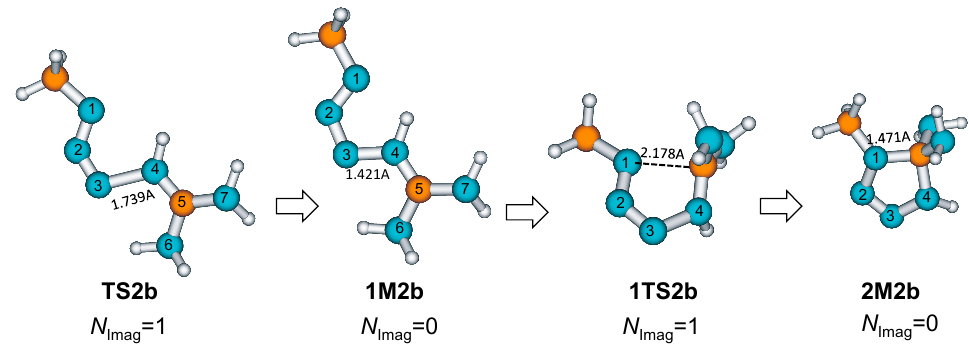
Figure 9. Stationary points on the potential energy surface along the reaction pathway describing the